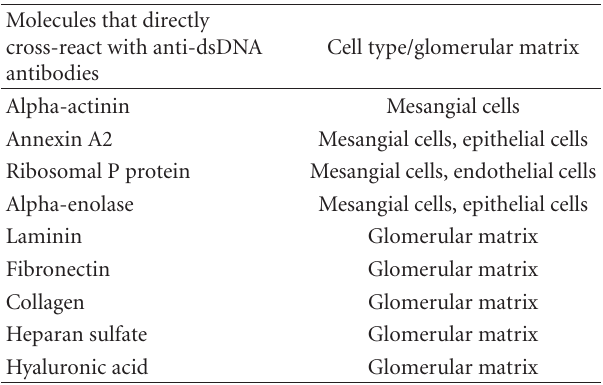
Table 2: Glomerular targets for anti-double-stranded (ds)-DNA antibodies [11, 12].